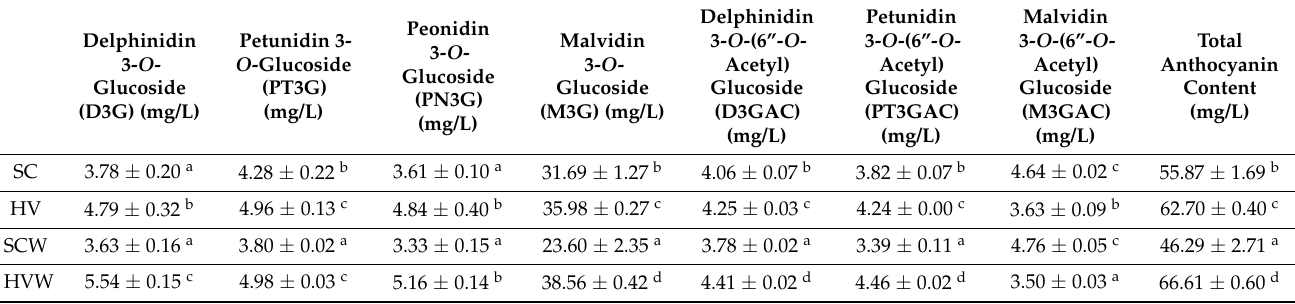
SC (fermentations with S. cerevisiae in stainless steel barrels); HV (fermentations with H. vineae in stainless steel barrels); SCW (fermentations with S. cerevisiae in oak barrels); HVW (fermentations with H. vineae in oak barrels). Values in the same column with the same letter are not significantly different ( p <